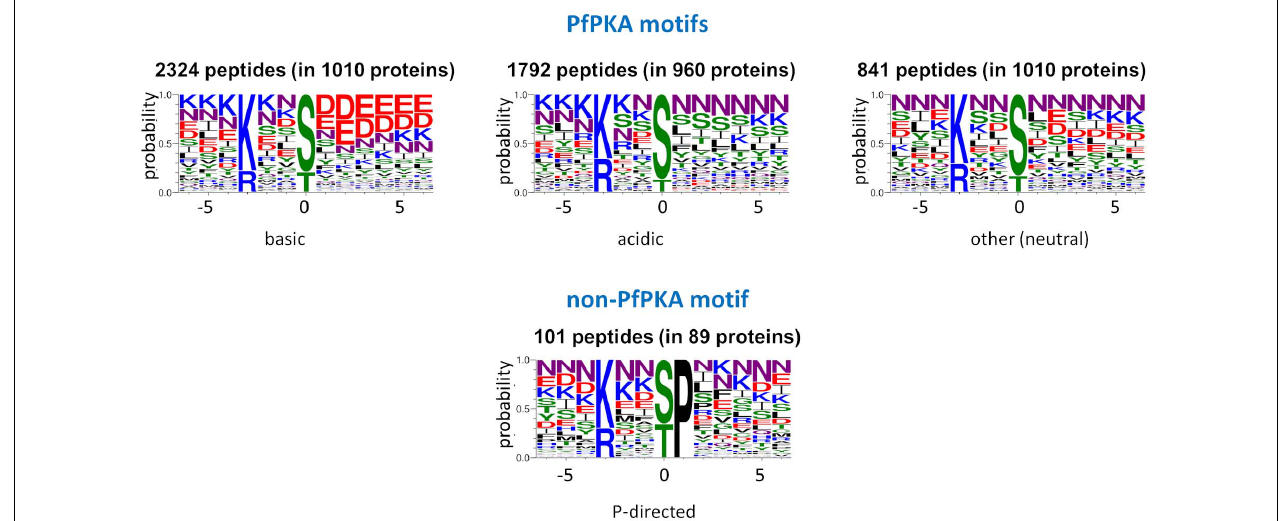
FIGURE 2 | Sequence logos of potential PKA substrate phosphorylation sites. Sequence logos of phosphorylation sites with a basic residue at position –3, extracted from 12 Plasmodium falciparum phosphoproteome studies (Treeck et al., 2011; Lasonder et al., 2012, 2015; Pease et al., 2013, 2018; Collins et al.,